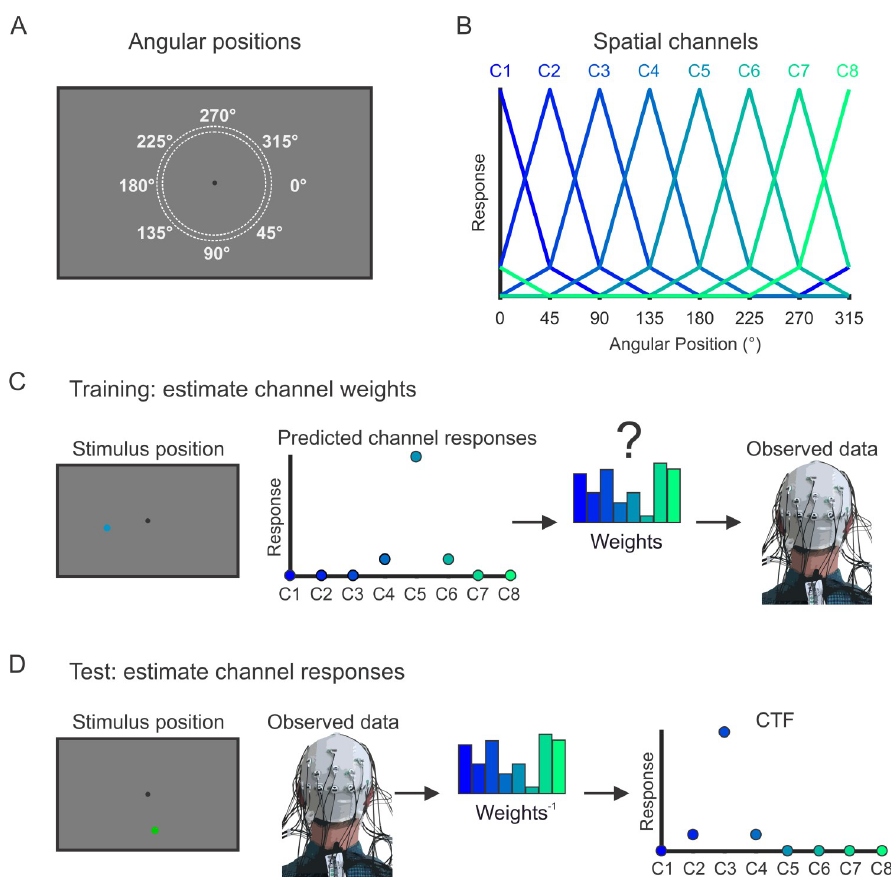
Fig 2. IEM procedure for reconstruction spatial CTFs. (A) The stimuli varied in angular position around the fixation point. Stimuli were categorized as belonging to 1 of 8 positions bins (a 45˚ wedge of positions), centered at 0˚, 45˚, and so forth. (B) We modeled power at each electrode as a linear combination of the 8 hypothetical spatial channels (C1– C8). The curves show the predicted response of the spatial channels across angular positions. (C) In the training phase of the analysis, we estimated the relative contributions of each of the 8 channels to power measured at each electrode (called “channel weights”). (D) In the test phase of the analysis, we used the channel weights obtained during training to estimate the channel responses from the multivariate pattern of power across electrodes. Critically, the data used in the training and test phases of the analysis were independent to avoid circularity. For details, see Materials and methods. Data are available at https://osf.io/47cmn/. CTF, channel-tuning function; IEM, inverted encoding